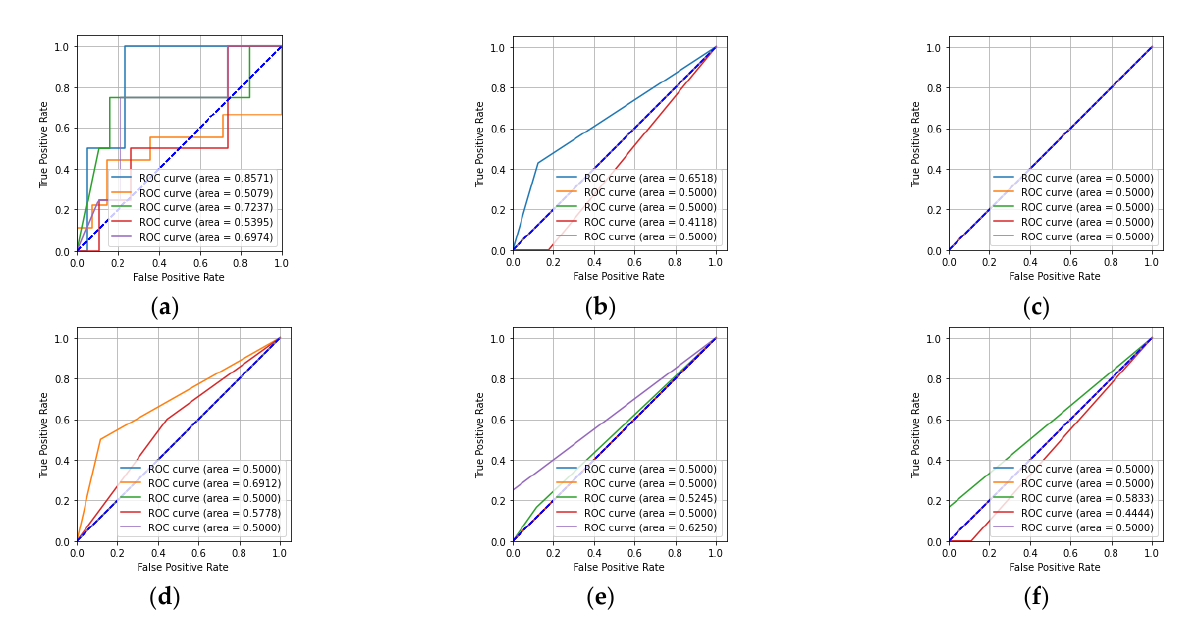
Figure 13. ROCs for whole information dataset: ( a ) CNN; ( b ) KNN; ( c ) MLP; ( d ) DT; ( e ) RF; ( f ) ET.